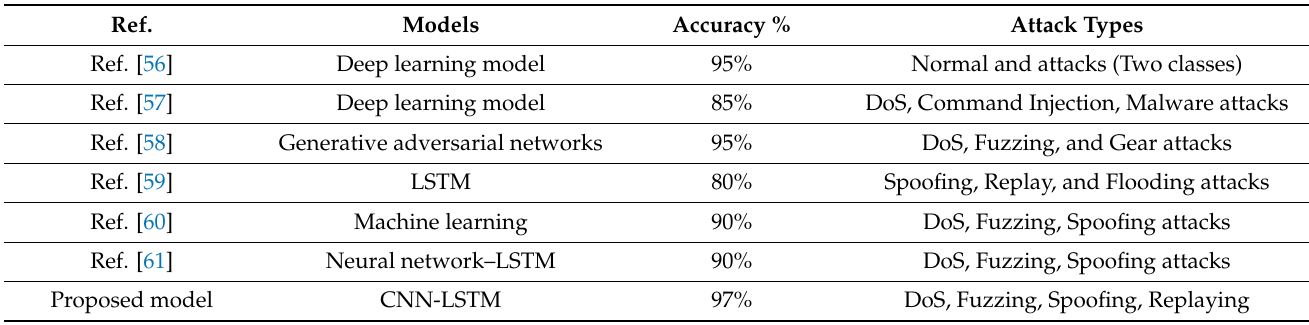
detection system for in-vehicle